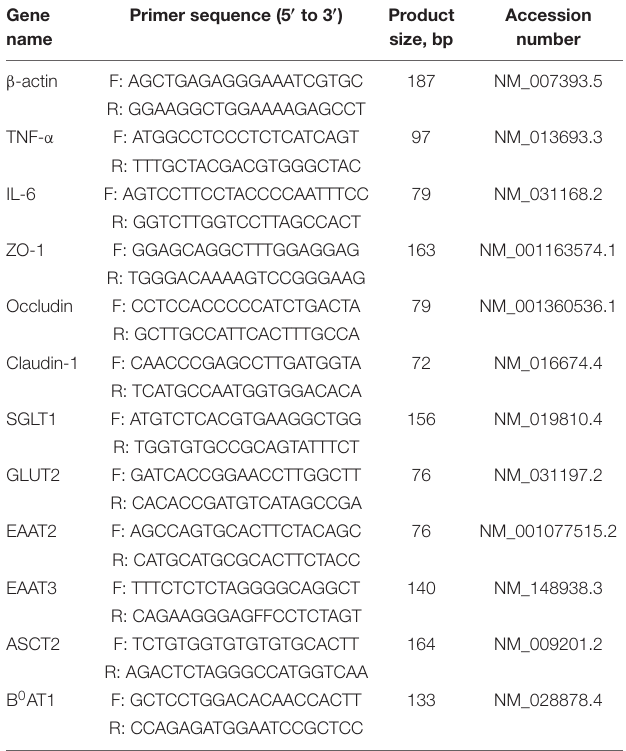
TABLE 1 | Primers used for real-time PCR analysis*.